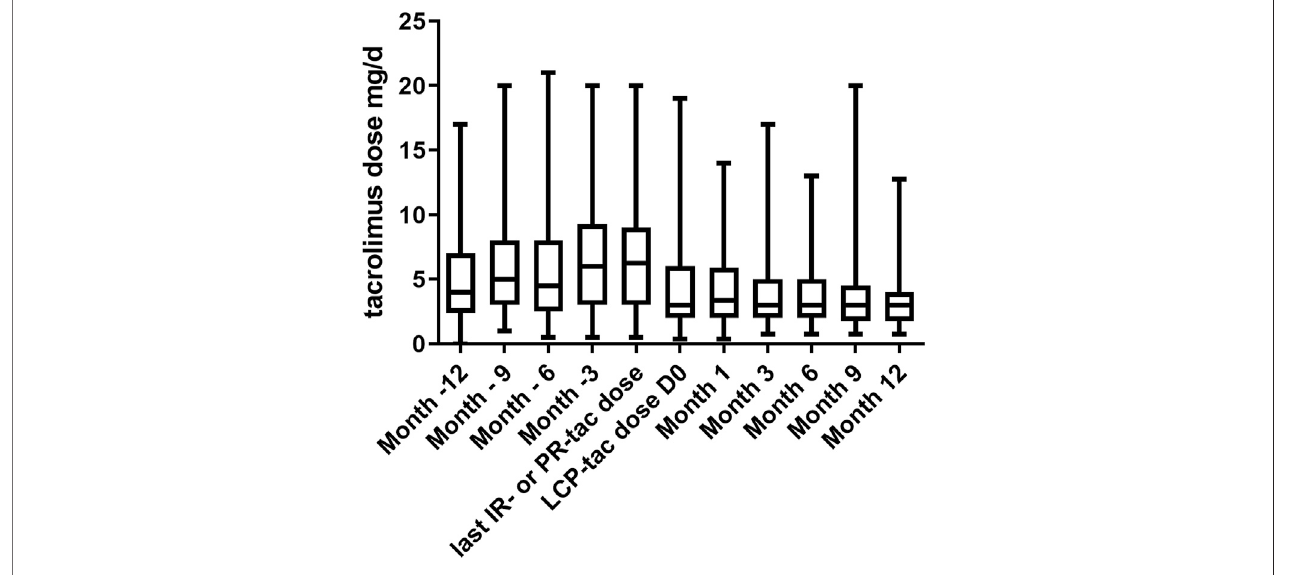
FIGURE 3 | Evolution of tacrolimus dose (mg/d) during the year before and after the switch from IR-tacrolimus or PR-tac to LCP-tacrolimus. IR-tac, immediate- release tacrolimus; PR-tac, prolonged-release tacrolimus; LCP-tac, extended-release LCP-tac. Results are presented as mean with SD.